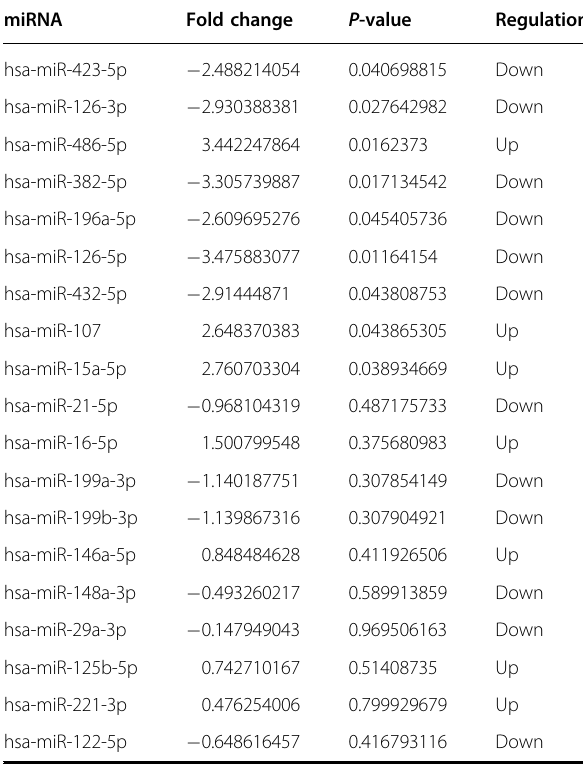
Table 2 Selected miRNAs differentially regulated in OA patients and normal